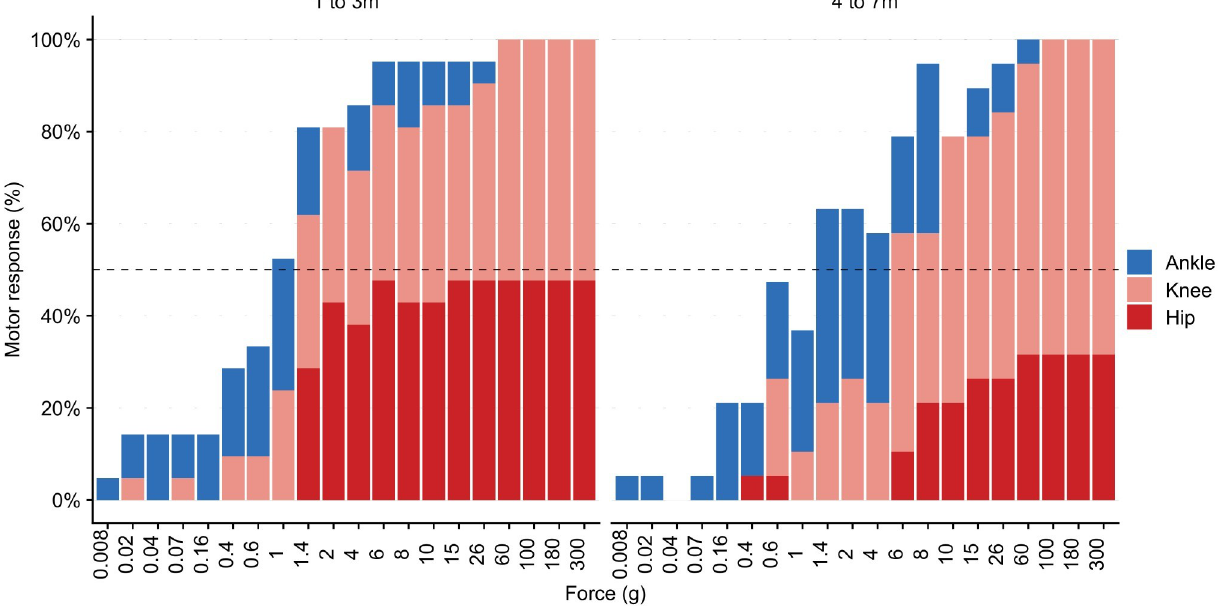
Fig 3. Progression of the different lower limb flexion responses to graded mechanical stimulation at age 1 to 3m (n = 21), and at 4 to 7m (n = 19) in the control group. The box plot shows the proportion of occasions that an ankle (blue), knee (pink) or hip (red) flexion was observed. https://doi.org/10.1371/journal.pone.0279705.g003 PLOS ONE | https://doi.org/10.1371/journal.pone.0279705 December30,